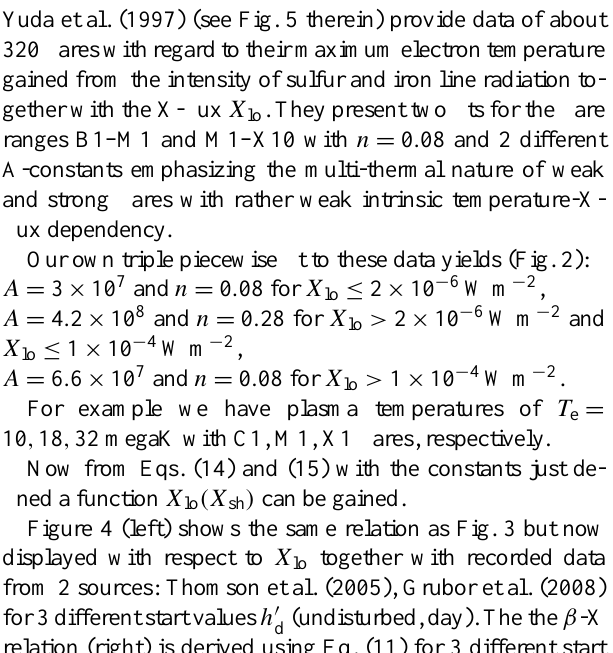
Fig. 5. Modeled e-density profiles from Nicolet and Aikin (1960): green: quiet day with zenith distances 70, 60, 50, 30, 0 degrees (from left to right); red: weak to strong flare conditions; dotted lines: equilibrium h 0 (km); β (km − 1 ) profiles from our model with the following values: quiet day: h 0 = 72, β = 0 . 28, h 0 = 70, β = 0 . 34, flares: h 0 , β according to Fig. 4, center